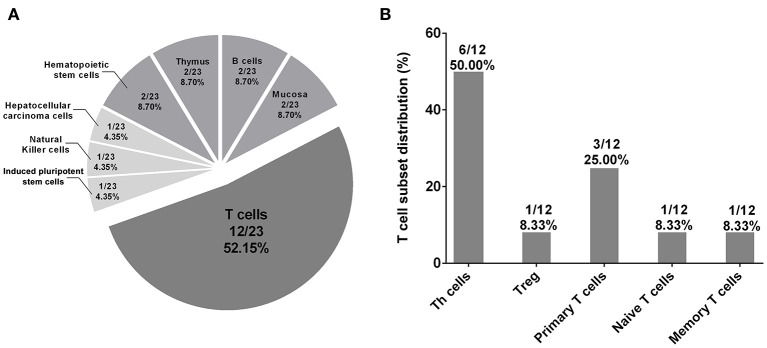
Tissue enrichment analysis of regulatory effects of rs3093023 and its proxies. (A) The significantly enriched tissues/cells (p < 0.05) of the regulatory effects of rs3093023 and its proxies. (B) The distribution of T cell subset enriched for regulatory effects of rs3093023 and its proxies. SNPs, single-nucleotide polymorphisms.